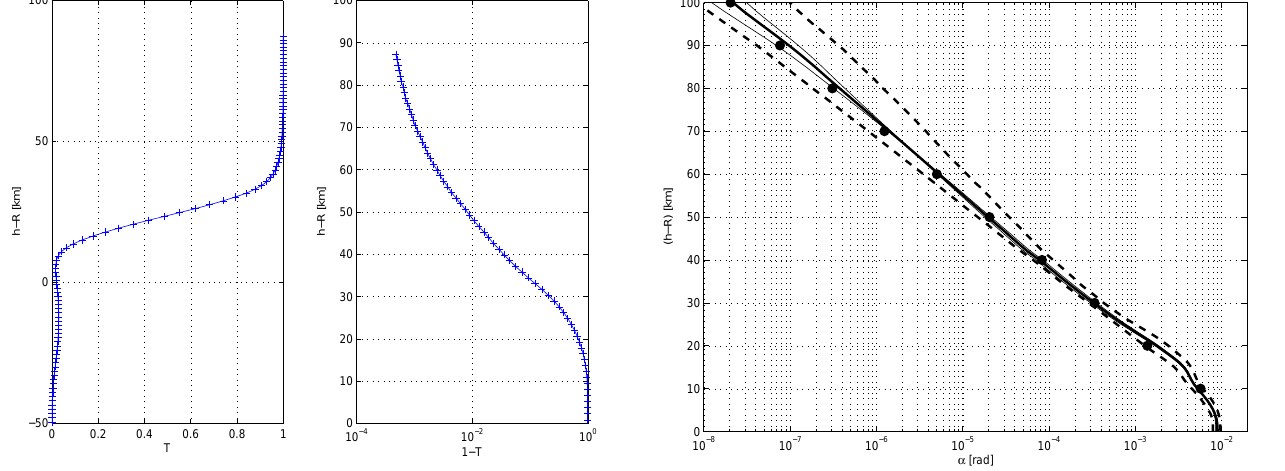
Figure 8. Median profile of atmospheric refraction angle obtained from the processing of 2836 ORA solar occultations observed be- tween Aug 1992 and May 1993. Full thick line: median profile. Full dashed lines: 16% and 84% percentiles of the retrieved profiles dis- tribution. Full thin lines: estimated errors due to signal digitization (16 bits). Full circles: refraction angles obtained by exact ray tracing for US76 standard conditions ( α b in Table